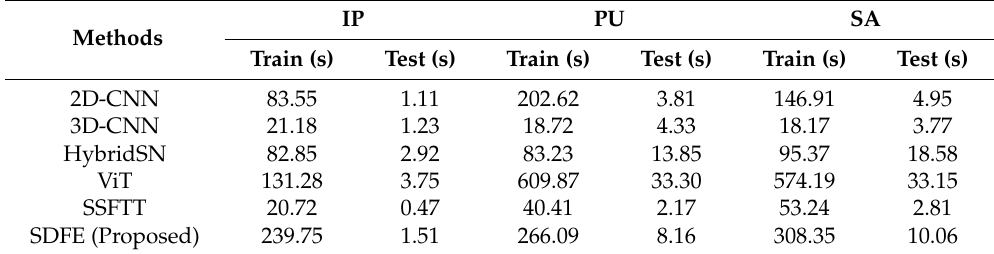
Table 13. Training time and testing time in seconds (s) between the contrast methods and the proposed methods.